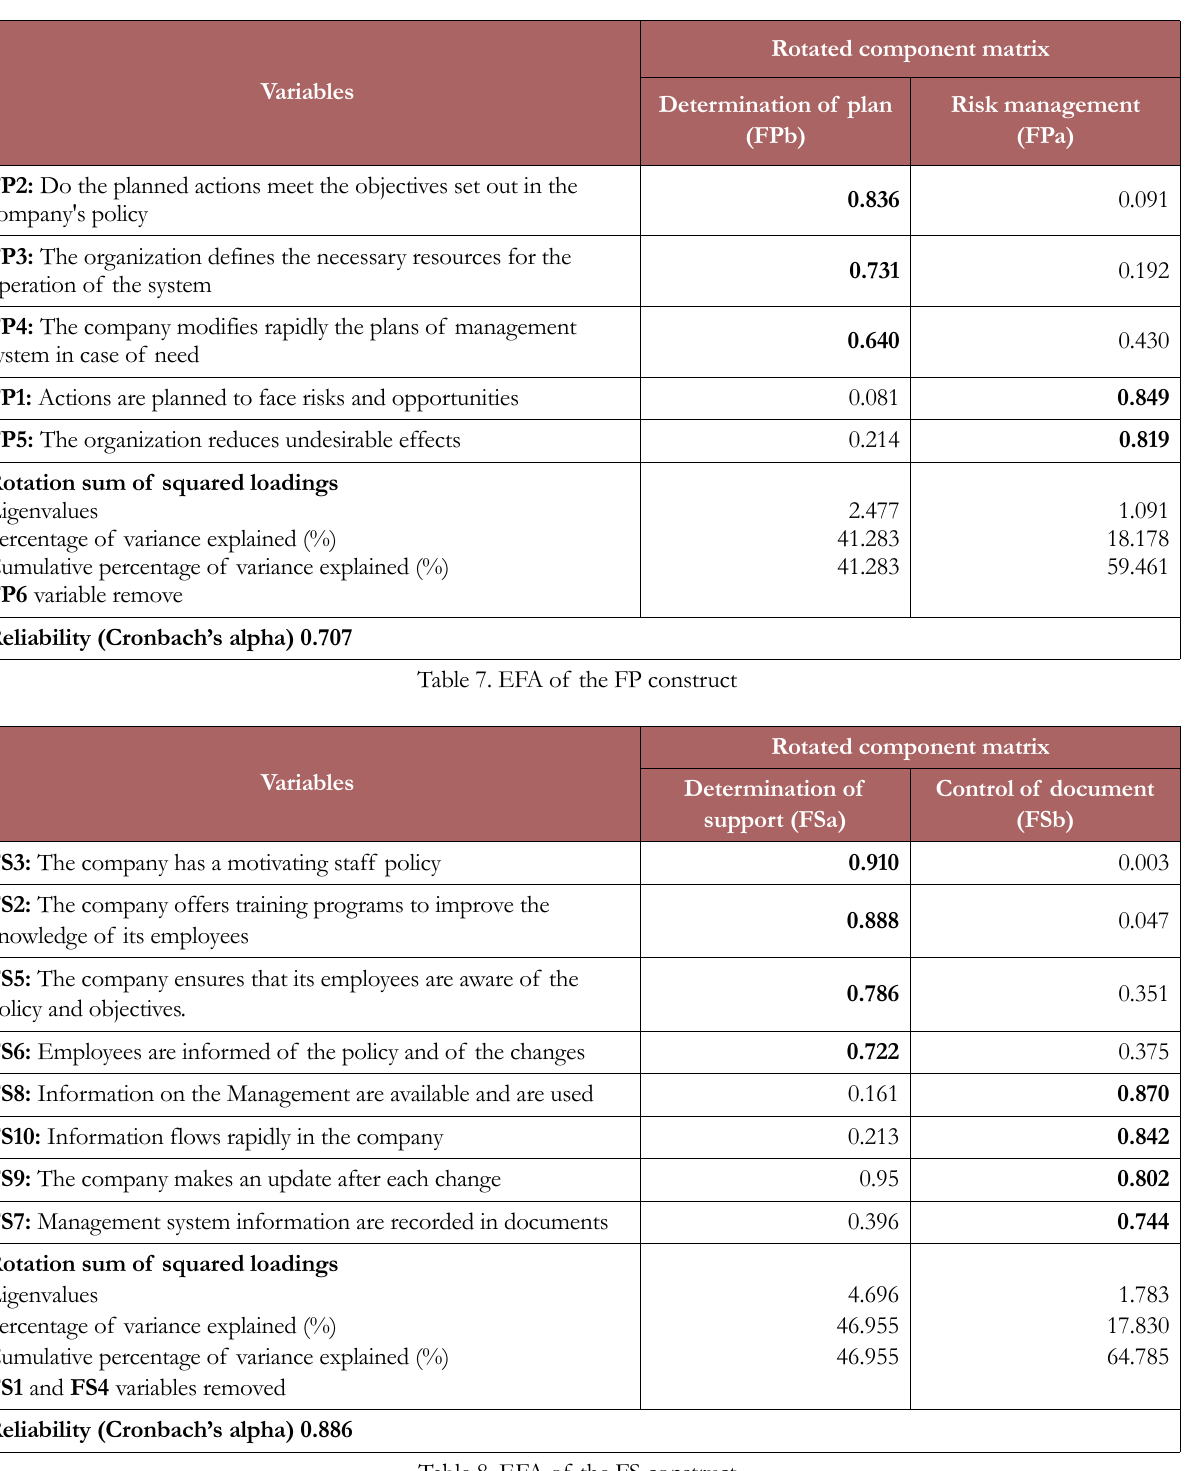
Table 8. EFA of the FS